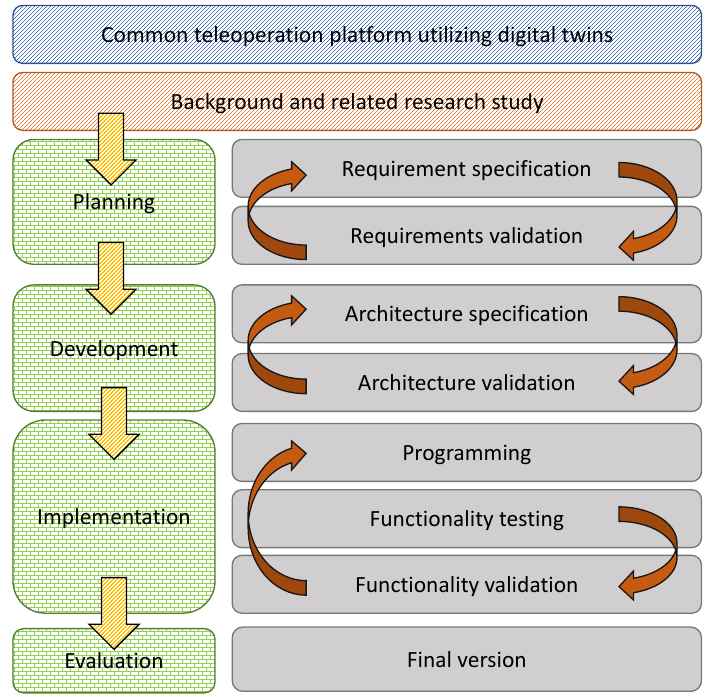
Figure 2. Methodology utilized in this work to develop and validate platform [16].